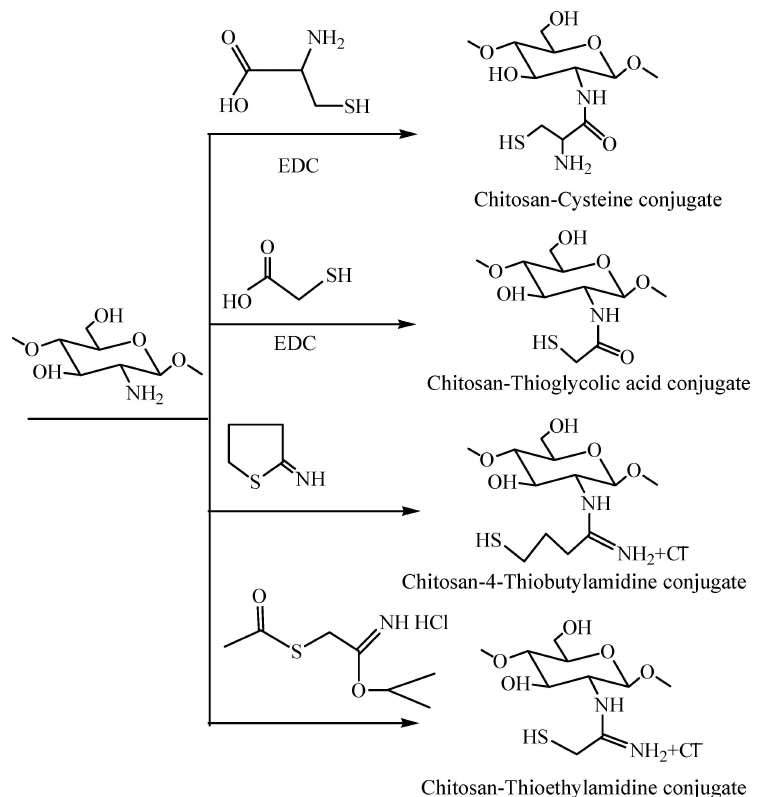
Figure 15. Preparation of thiolated